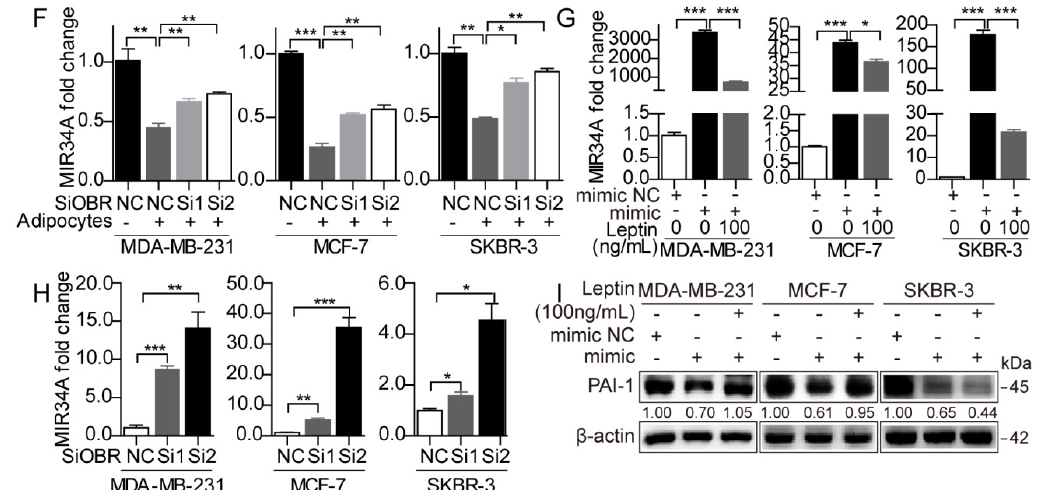
Figure 7. Leptin/OBR induces PAI-1 expression by repressing miR-34a. ( A ) Prediction of miRNAs targeting PAI-1. A total of 25 potential PAI-1-targeting miRNAs were simultaneously predicted by TargetScan and miRcode databases. ( B ) Conservative binding site for miR-34a at the 3 ′ UTR of PAI-1. ( C ) Prognostic value of miR-34a in patients with different types or grades of breast cancer by KM plotter analysis. ( D ) Transwell migration assays of MDA-MB-231 cells after transfection with the miR-34a mimic (100 nM, 48 h). Scale bar: 100 µ m. ( E ) Breast cancer cells transfected with the miR-34a mimic (100 nM, 48 h) were collected for western blot analysis. ( F ) qRT-PCR. OBR was depleted in breast cancer cells with siRNA followed by adipocyte coculture for 72 h, and then miR-34a expression was detected. ( G ) Expression of miR-34a was measured in breast cancer cells by qRT-PCR after transfection with the miR-34a mimic (100 nM, 48 h) and treatment with leptin (100 ng/mL, 24 h). ( H ) Breast cancer cells transfected with OBR-specific siRNA were collected for qRT-PCR to detect miR-34a expression. ( I ) After transfection with the miR-34a mimic (100 nM, 48 h), breast cancer cells were further treated with leptin (100 ng/mL, 24 h), and then the PAI-1 levels were examined by western blot. The results are presented as the mean ± SEMs from three independent experiments, * p < 0.05, ** p < 0.01, *** p < 0.001.